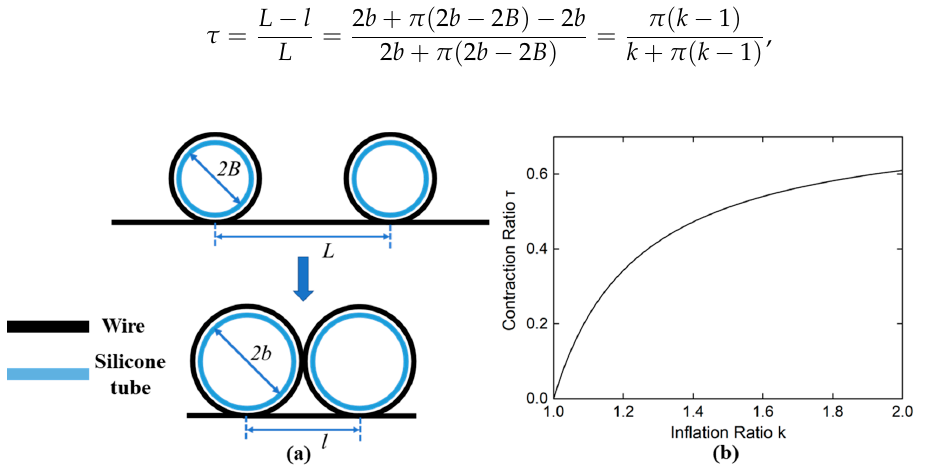
Figure 3. ( a ) The contraction ratio model of HPAM ( b ) the plot of inflation ratio changing with contraction ratio.